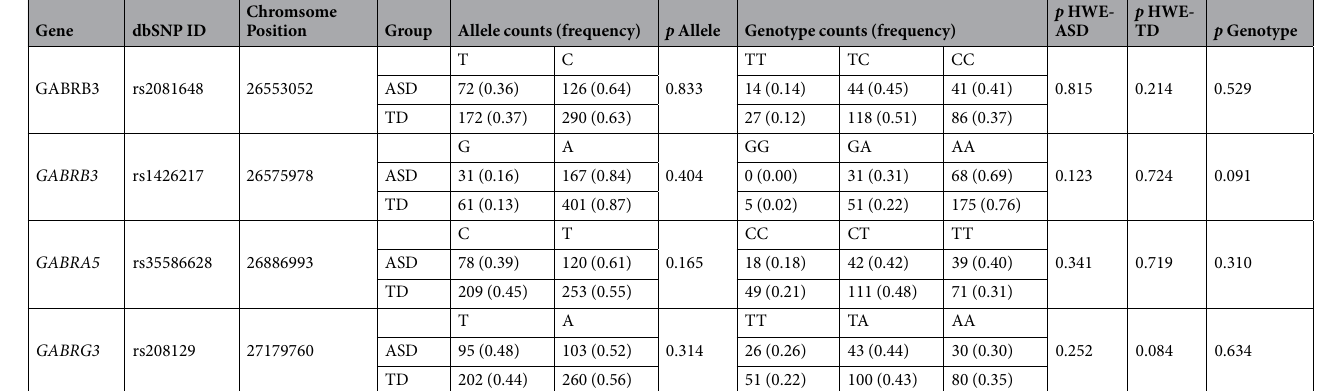
Table 1. Genotypic and allelic frequencies of four SNPs in three GABA A receptor genes and association analysis between the ASD and TD groups. All four SNPs locate in intron regions. ASD, autistic spectrum disorders; HWE, Hardy-Weinberg equilibrium; SNP, single-nucleotide polymorphism; TD, typical developing.